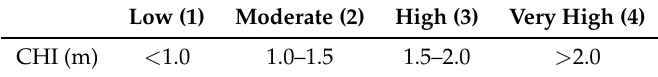
Table 2. Ranking needed to evaluate the Coastal Hazard Index